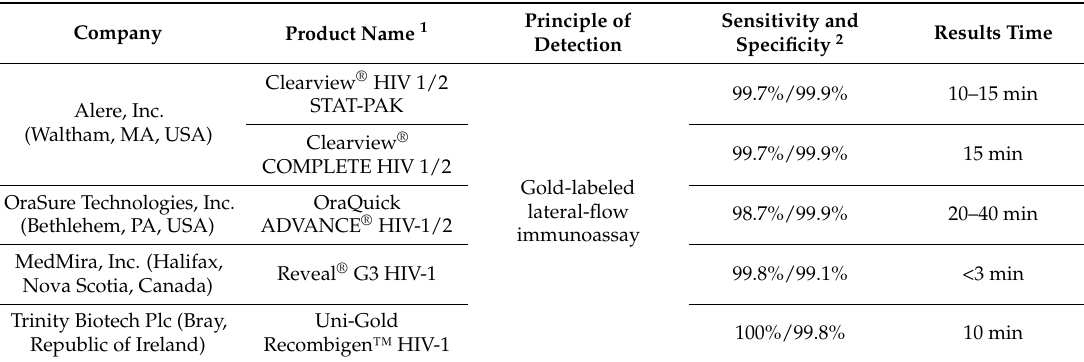
Table 1. LFA AuNP-based systems on the